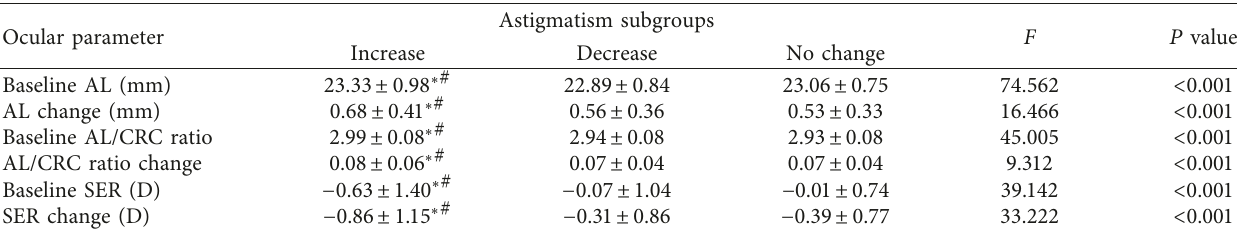
Table 5: Comparison of ocular biometry among the three astigmatism change